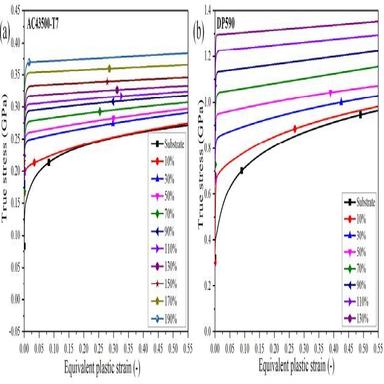
True stress–equivalent plastic strain curves at different pre-strain levels for (a) AC43500-T7 and (b) P590.